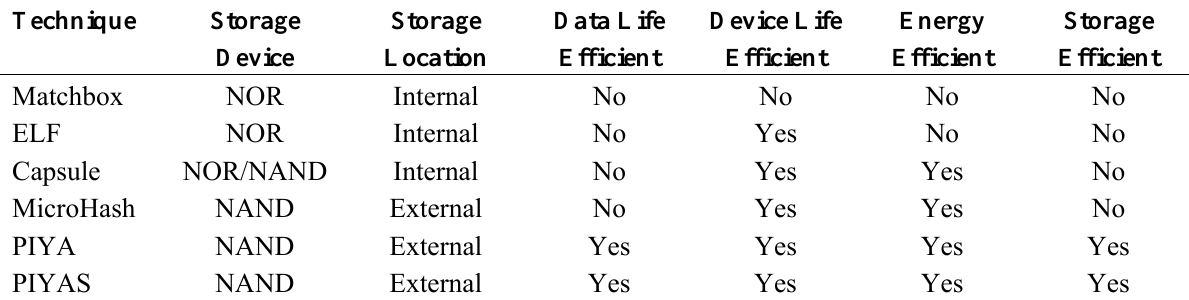
Table 1. Comparison of PIYAS with previous